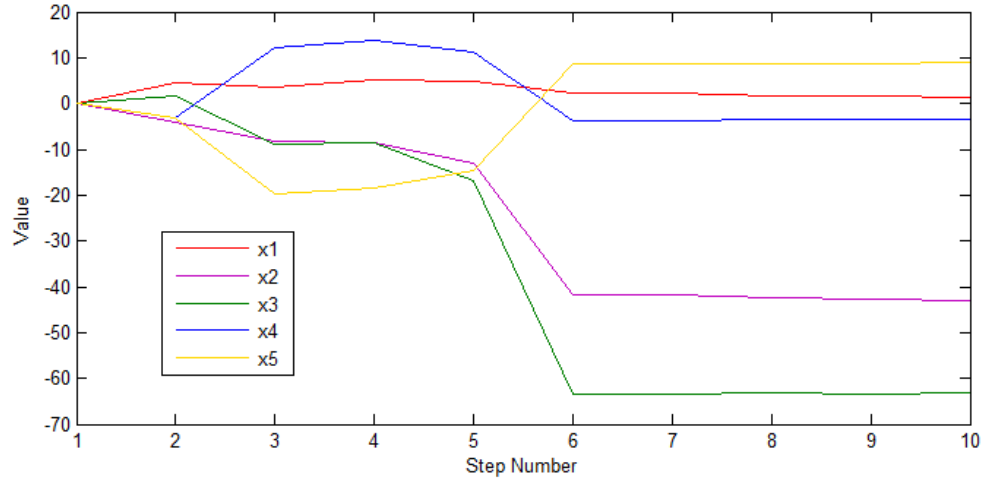
Figure 7. Element change of state vector X .